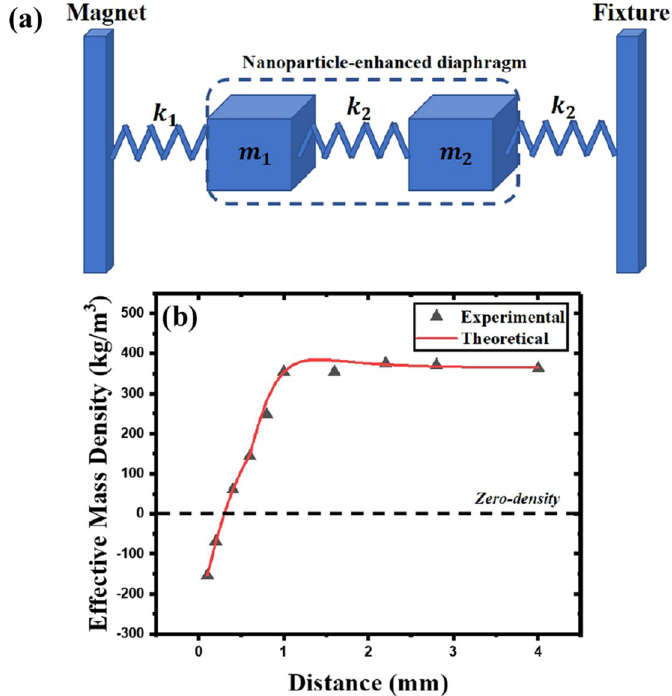
Figure 4. ( a ) Simplified model of magnet and magnetic nanoparticle-enhanced diaphragm. ( b ) Experimentally measured and theoretically calculated effective relative density of the diaphragm when the magnet is at different positions from the diaphragm (the black dotted line is the zero-density